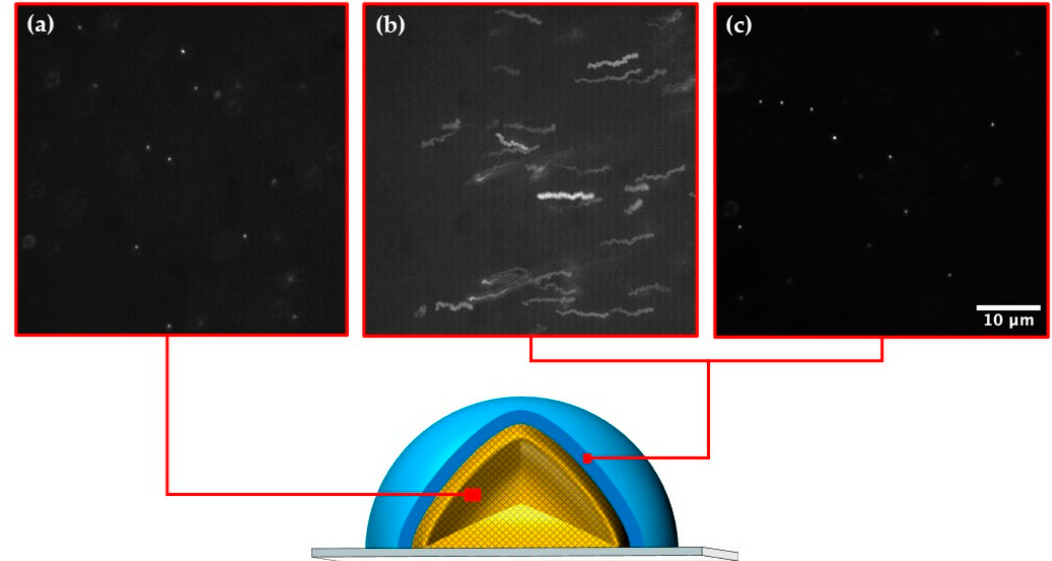
Figure 4. Schematic diagram of a partially photo-crosslinked PEGDA particle and epi-fluorescence micrographs of a “maximum intensity Z-projection” (processed on ImageJ) showing the trajectories of fluorescent polystyrene nanoparticles in different regions of the particle: ( a ) Polymerised core region after 30 s; ( b ) Unpolymerised shell region after 30 s; ( c ) Fully polymerized shell region after 60 s of UV light exposure at 75 mW/cm 2 .